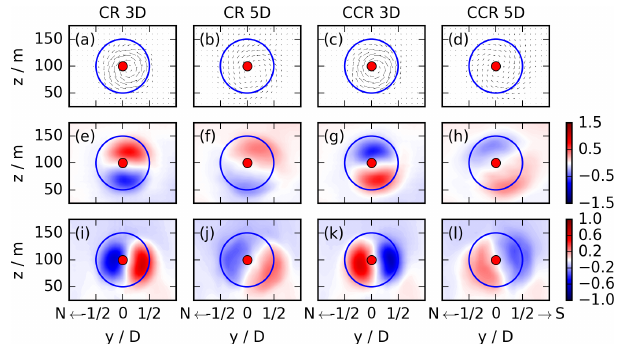
Figure 5. y – z cross sections of the EBL wind-turbine simulations for CR and CCR at x = 3D and 5D. The first row (a–d) presents the ( v , w ) vectors in the y – z plane, the second row (e–h) the merid- ional wake velocity v , and the third row (i–j) the vertical wake ve- locity w . The blue contour represents the circumference of the actu- ator. The streamwise flow is from the west, and these cross sections correspond to a view towards the east downwind through the turbine with north on the left and south on the